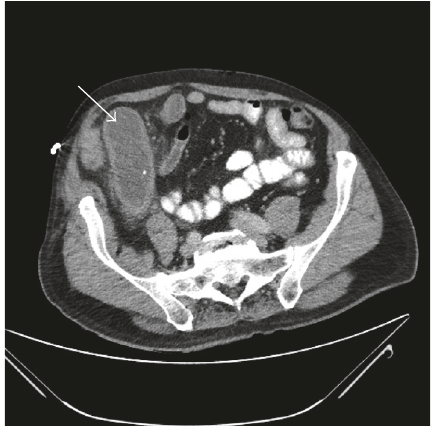
Figure 1: Initial CT colonogram showing a well-circumscribed ovoid soft tissue mass in the small bowel mesentery.